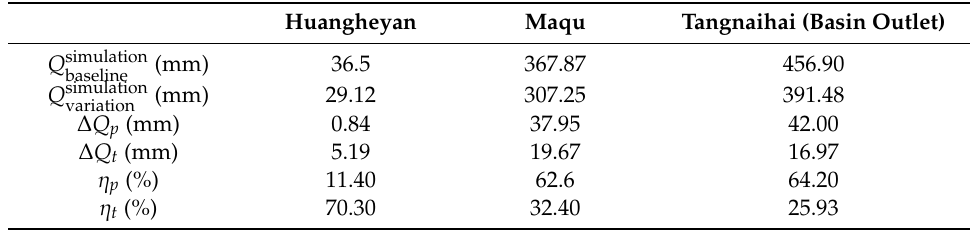
Figure 7. Relative contributions of temperature, precipitation, and other climate variables to changes in observed runoff across the HRYR. Table 4. Proportional influence of temperature and precipitation on decreases in runoff in the HRYR, estimated with the SWAT model for different stations.